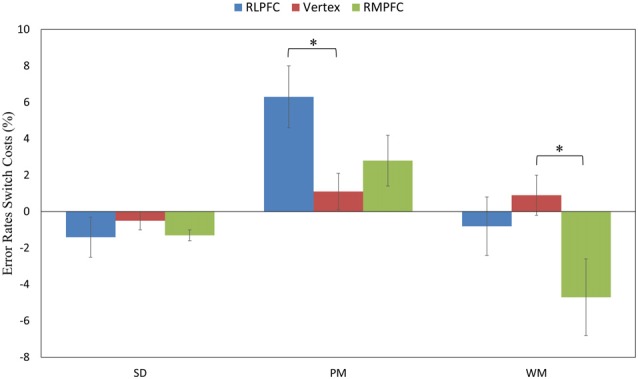
The switch costs of ERs across the three tasks (SD, PM and WM), and three stimulation sites: RLPFC (blue), vertex (red), RMPFC (green). *p < 0.05, error lines represent standard error of mean.